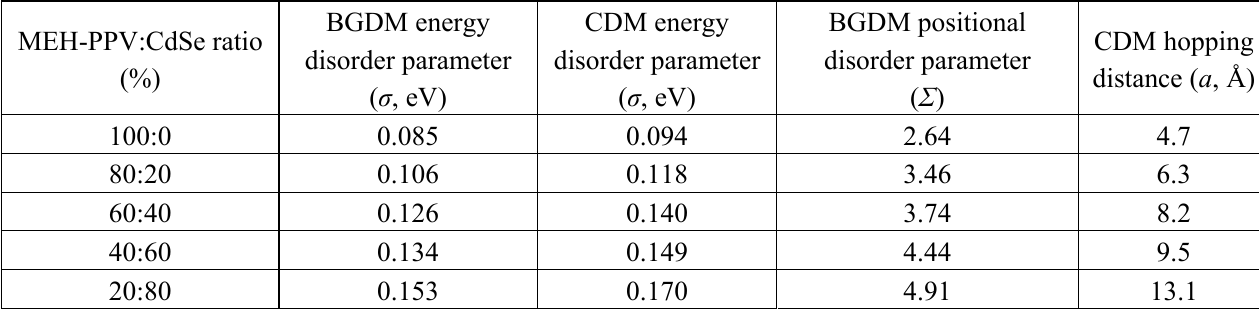
Table 1. The BGDM and CDM disorder model parameters of MEH-PPV-CdSe CQD thin films with different MEH-PPV:CdSe